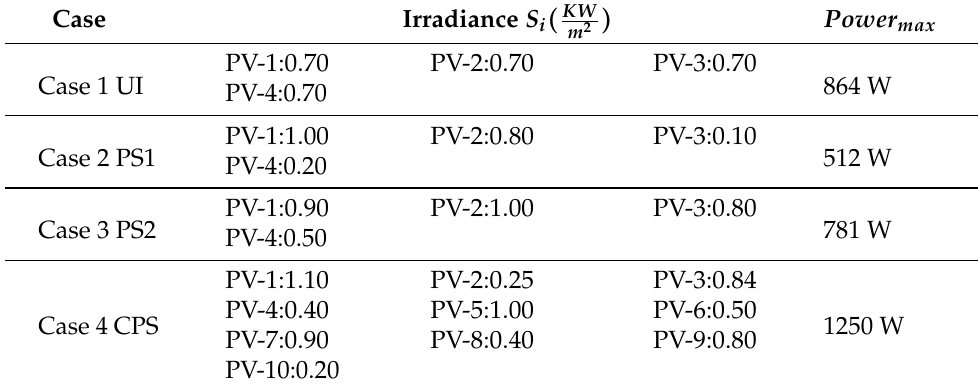
Table 2. P-V and I-V characteristic curves at different irradiance values.